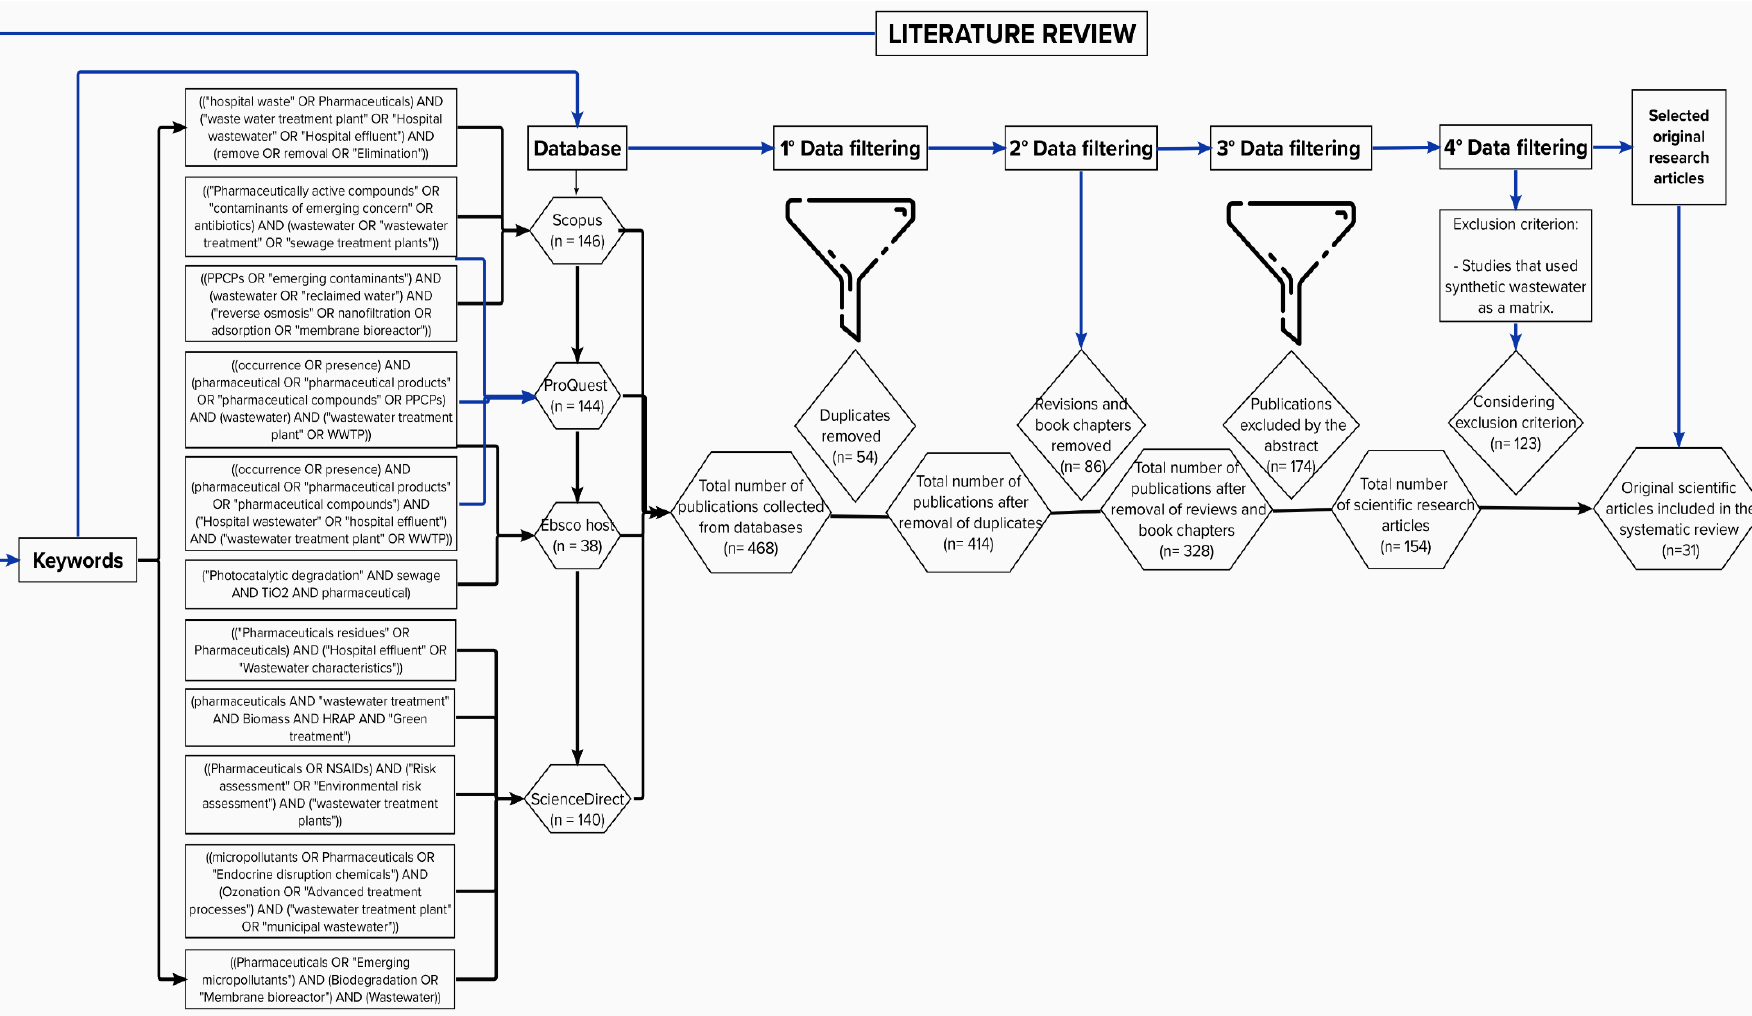
Figure 2. Outline of the search procedure and identification of articles included in this review.